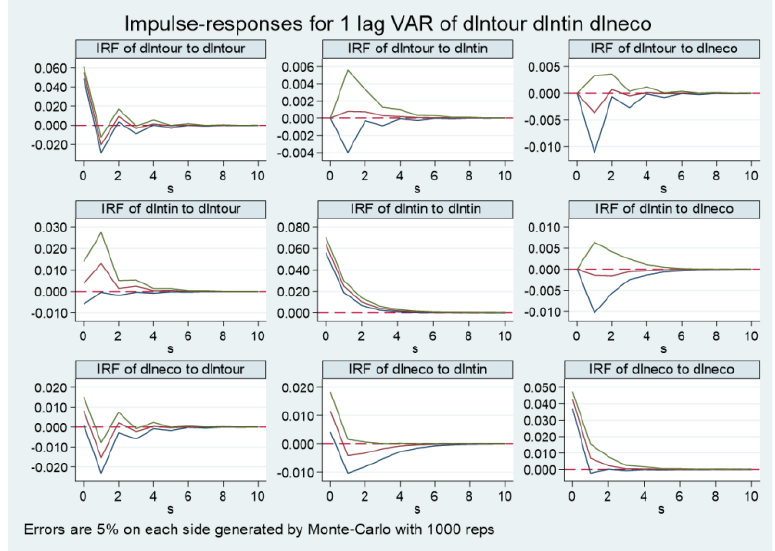
Figure 4. Regional division map of China (source: made by authors).